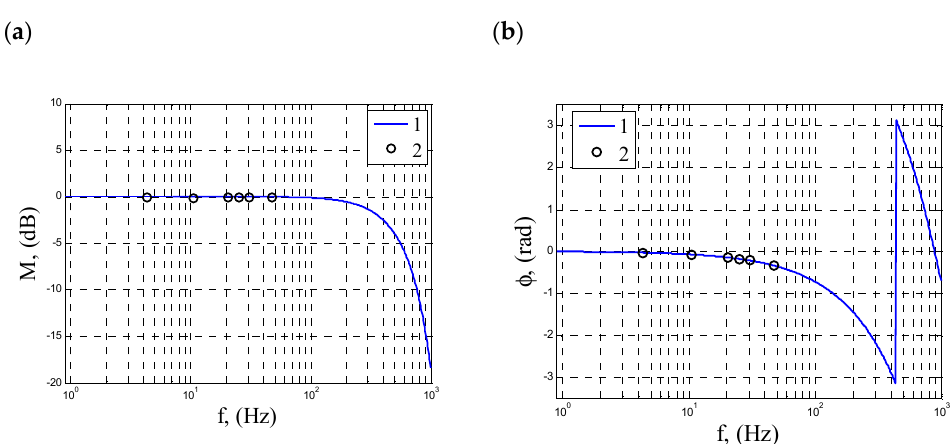
Figure 9. Points of the frequency characteristics of the ( a ) amplitude and ( b ) phase of the tested analog filter used in the measuring line of the voltage supplying the motor, determined by the suggested method, against the theoretical Bodé characteristics of this filter; 1—theoretical frequency characteristics of the filter, 2—results of the suggested method.